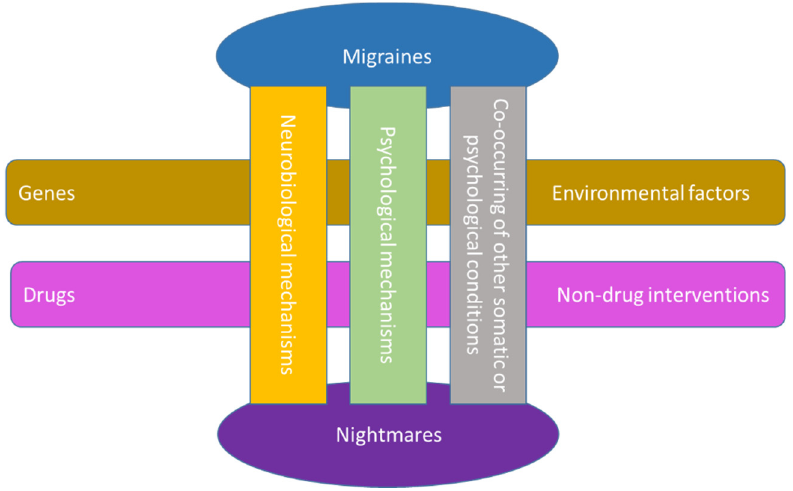
Figure 2. The proposed link between nightmares and migraine, and the potential factors influencing this link.